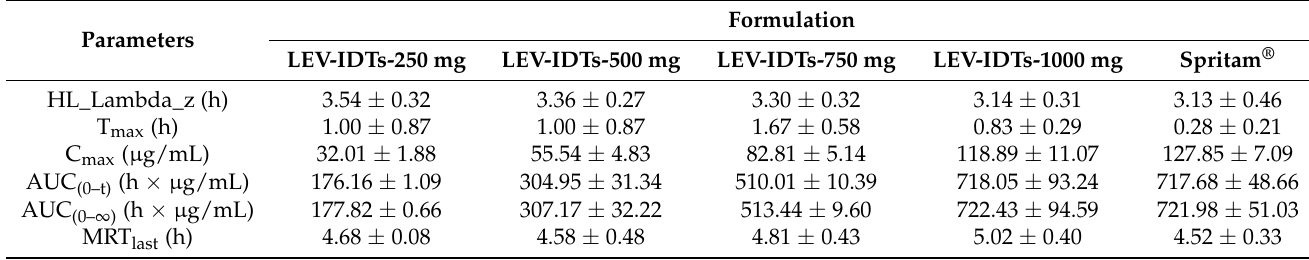
Table 3. Key pharmacokinetic parameters after oral administration of LEV in dogs ( n = 3).